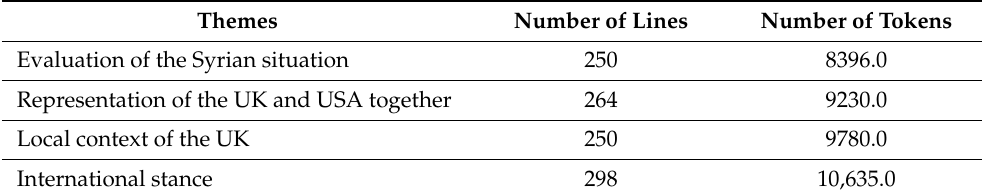
Figure 1. Architecture of the long short-term memory (LSTM) neural network (cited from [25]). Table 1. Total number of concordance lines and tokens for each theme.